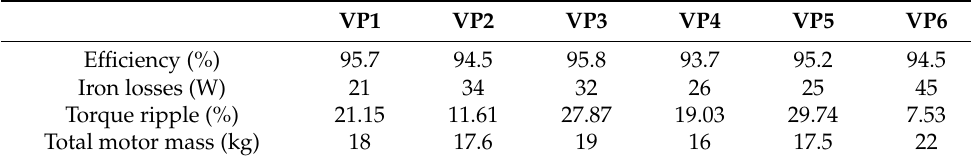
Table 7. Performance